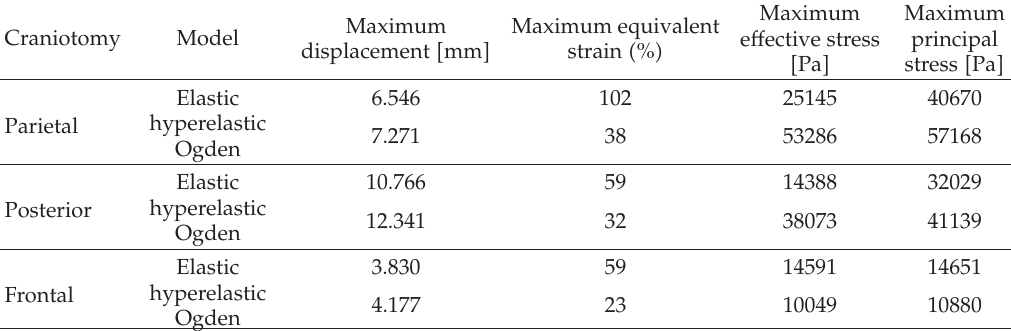
Table 5: Comparison of maximum displacement, equivalent strain, e ff ective stress, and principal stress for parietal, posterior, and frontal